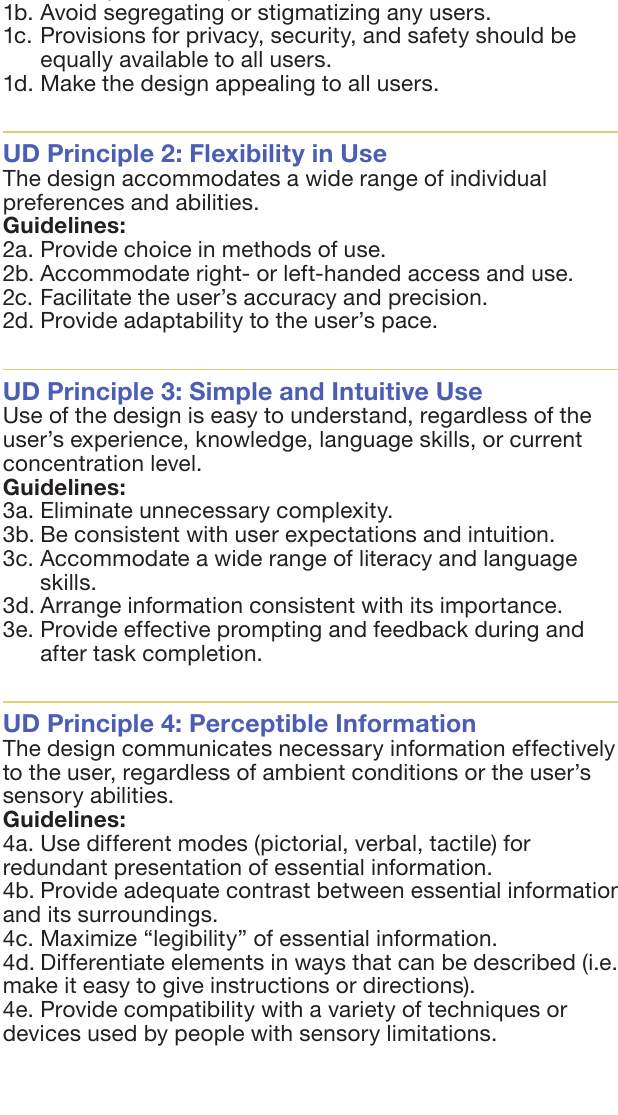
Table 1: Principles of Universal Design (North Carolina State University) 1 UD Principle 1: Equitable Use The design is useful and marketable to people with diverse abilities.